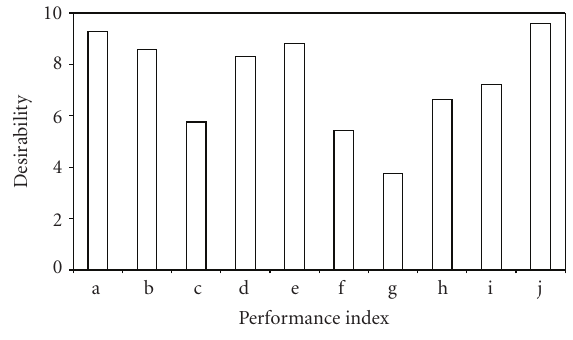
Figure 4: Mean scores of performance indices for RIT incubators (a) set point accuracy, (b) maintainability (defined as ease of availability of system’s spare parts and maintenance engineers in Nigeria), (c) ease of hood accessibility, (d) heating transient response, (e) sensitivity and response to erratic power supply, (f) humidification, (g) system aesthetic appreciation, (h) operation inherent noise, (i) response to high ambient temperatures, and (j) cost of system procurement.